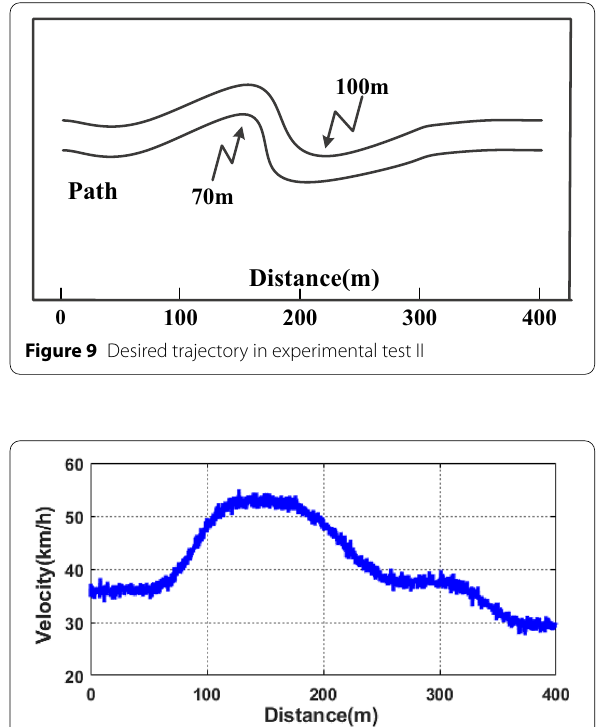
Figure 10 Longitudinal velocity in experimental test